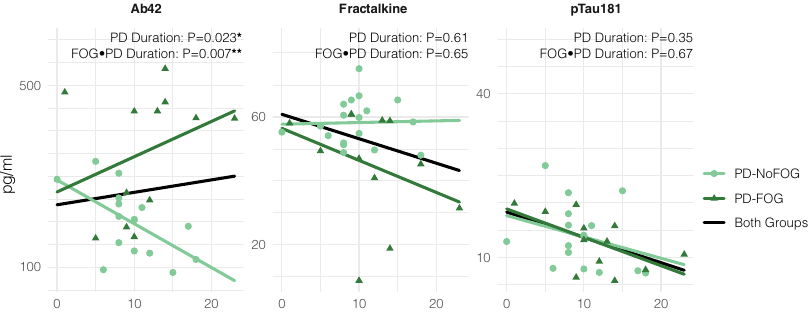
Fig. 3 Association between CSF markers (A β 42, fractalkine, and p-Tau 181 ) and disease duration, strati fi ed by presence of FOG. Dark and Light Green lines represent separate linear regressions of marker level onto PD duration for PD-FOG and PD-NoFOG, respectively. Gray lines represent linear regressions for both groups combined. P values re fl ect multivariate linear models with terms for age, sex, FOG, PD duration, and interaction between FOG and PD